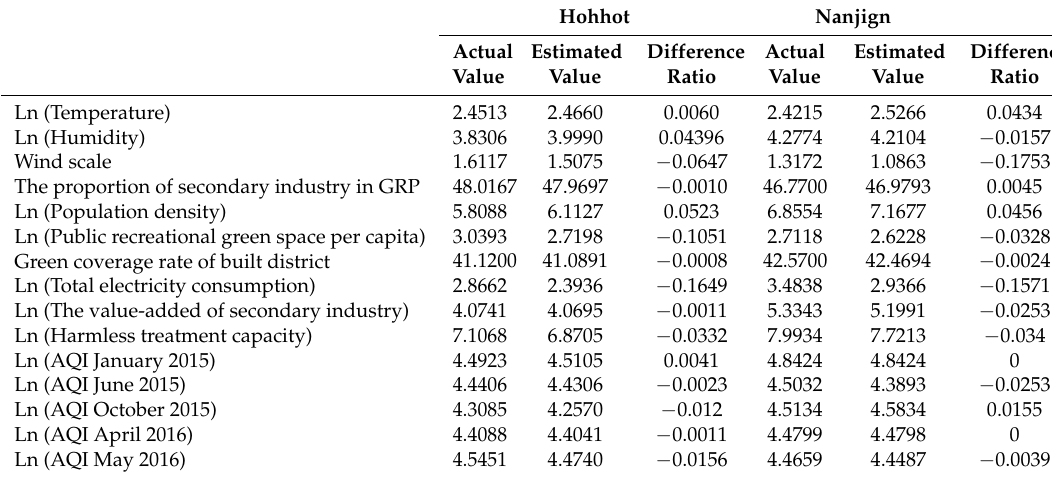
Table 4. The actual value and the estimated value of predictive